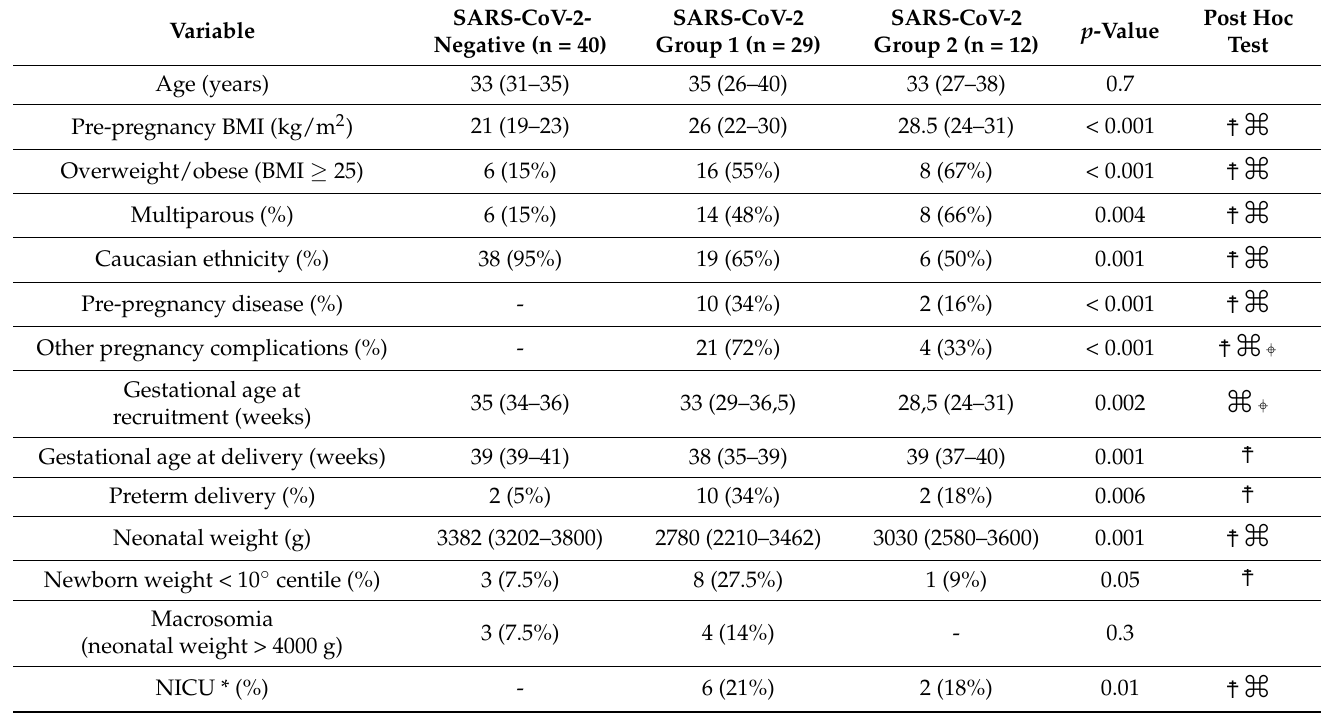
Table 1. Demographic and clinical data of the three groups. The values are expressed as medians and interquartile ranges, or as percentages of the total patients in each group and the absolute number of cases, as appropriate.